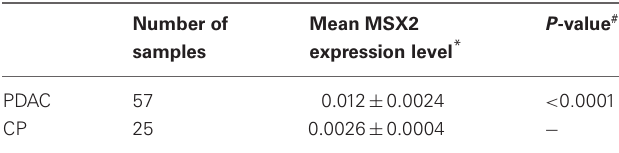
Table 6 | MSX2 expression levels in ERCP brush samples (Satoh et al., 2011).